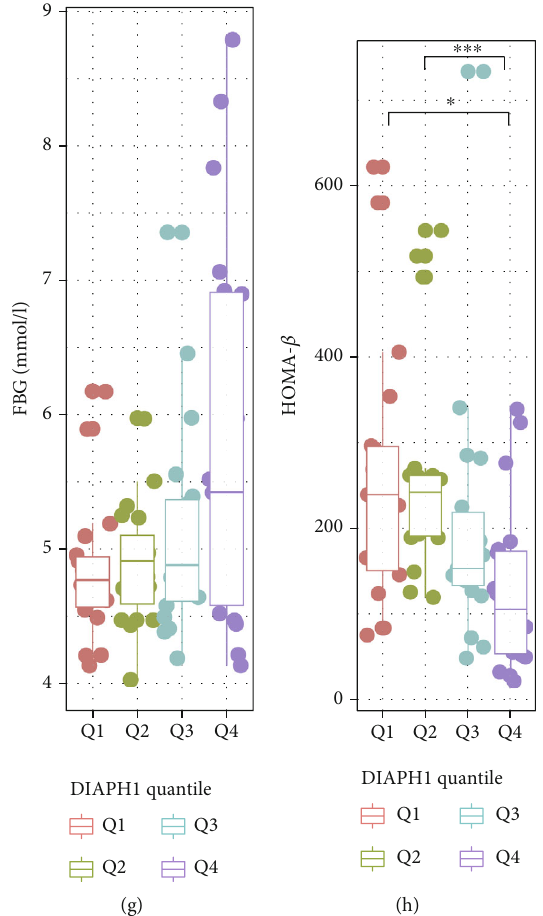
Figure 2: FBG and HOMA- β levels in the PCOS and control groups and DIAPH1 quantile groups. (a) FBG levels in the control and PCOS group. (b) FBG levels in the normal-weight (NW) and overweight/obese (OW) subgroups of the control and PCOS groups. (c) HOMA- β levels in the control and PCOS group. (d) HOMA- β levels in the normal-weight (NW) and overweight/obese (OW) subgroups of the control and PCOS groups. (e) DIAPH1 levels by FBG in the PCOS group: FBG < 5 represented a relatively low level of FBG, and FBG > 5 represented a relatively high level of FBG. (f) DIAPH1 levels by HOMA- β in the PCOS group: HOMA − β < 200 represented a relatively low level of HOMA- β , and HOMA − β > 200 represented a relatively high level of HOMA- β . (g) FBG levels by DIAPH1 quartiles in the PCOS group. (h) HOMA- β levels by DIAPH1 quartiles in the PCOS group. Data are presented as interquartile ranges (25 – 75%). The Mann – Whitney U test was performed to compare variables between the two groups. The Kruskal-Wallis test followed by pairwise comparisons using the BWS all-pairs test was performed for the four subgroups. ∗ P < 0 : 05 , ∗∗ P < 0 : 01 , ∗∗∗ P < 0 : 001